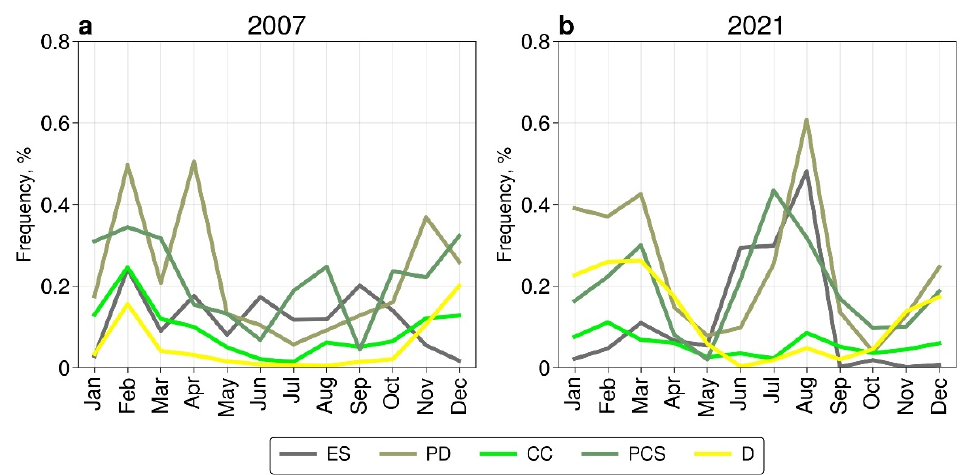
Figure 8. Occurrence frequency of each CALIOP aerosol type for ( a ) 2007 and ( b ) 2021. Aerosol